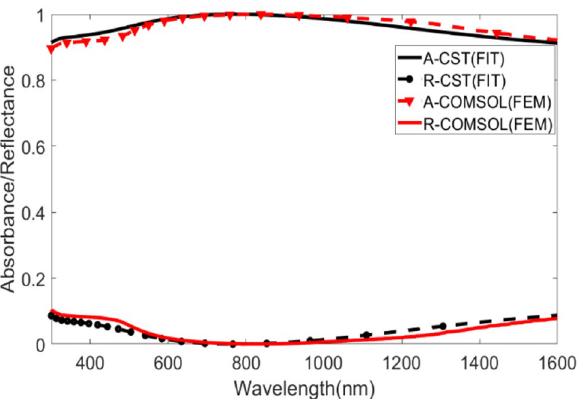
Figure 6. Visualization of the numerical verification of the design with FEM method in COMSOL Multiphysics simulation software and FIT method in CST MWS simulation software of the proposed design in normal incidence with TEM mode. Insets: Demonstration of simulation setup in both simulation software.